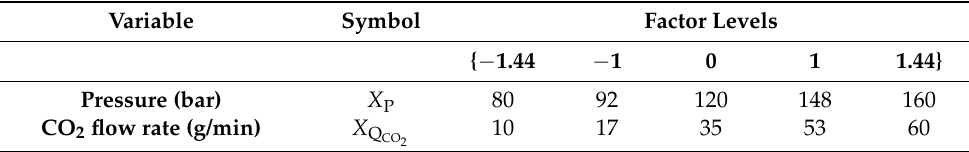
Table 6. Codification and levels of the two independent variables for the factorial design of SAF